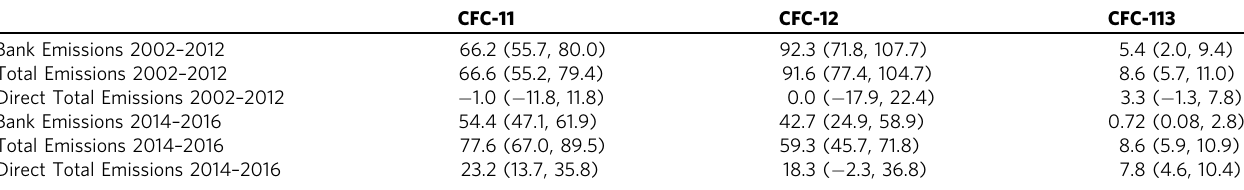
Table 2 Median emissions estimate (95% CI) by source for the unexpected emission scenario. Values are reported in